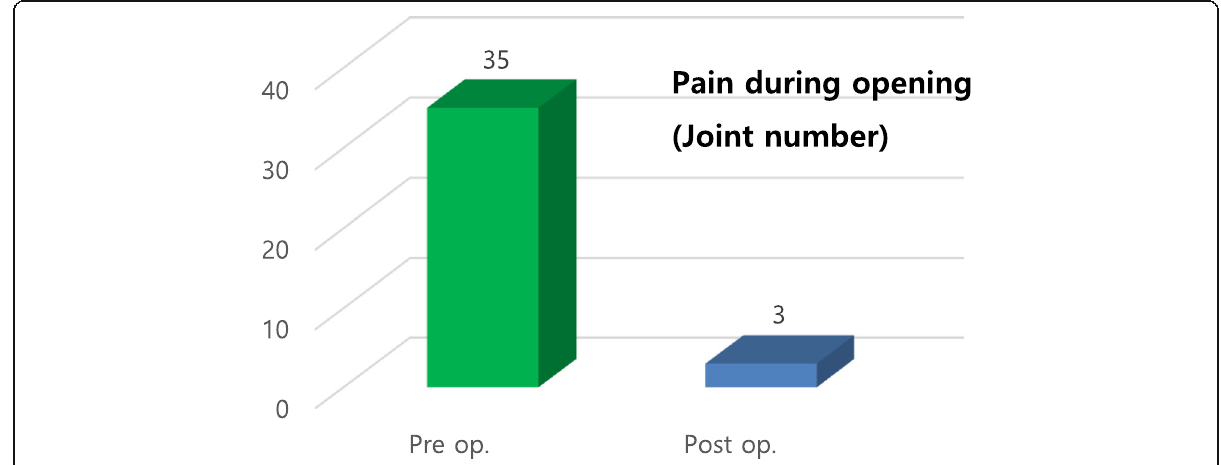
Fig. 10 Evaluation of preoperative (Pre op.) and postoperative (Post op.) TMJ pain